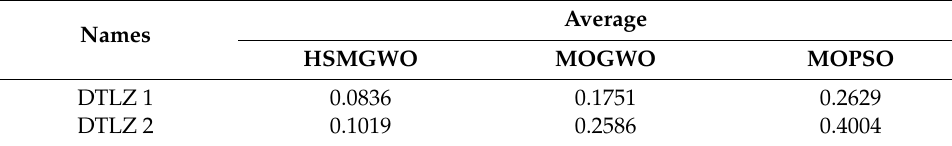
Table 1. Test results for